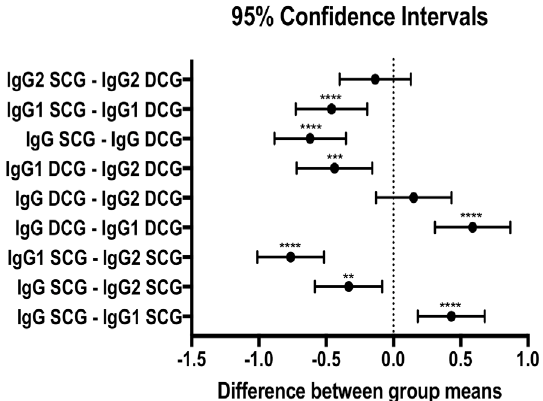
Figure 2. The 95% con fi dence intervals of the differences between the mean values of the IgG, IgG1, and IgG2 titrations obtained by ELISA, considering the variable of clinical state. The vertical dotted line indicates the absence of any differences between the means evaluated. ** , p =0.0022; *** , p = 0.0002; **** , p <